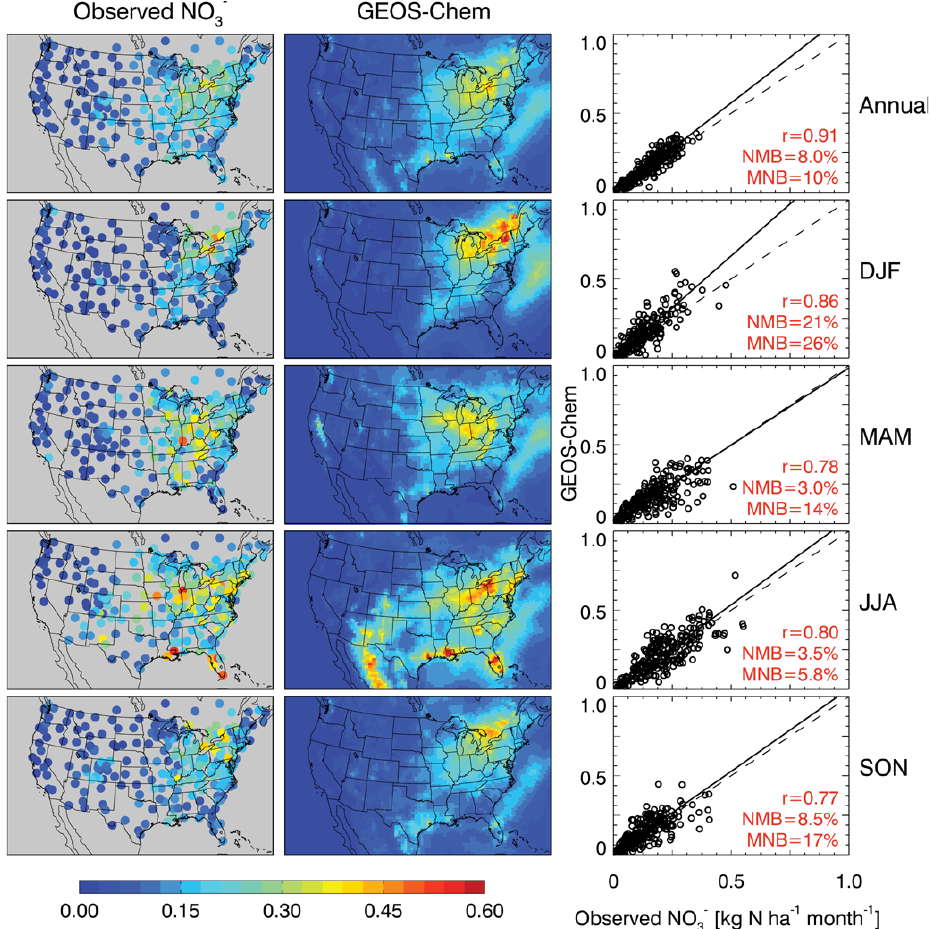
Fig. 3b. Same as Figure 3a but for nitrate (NO −